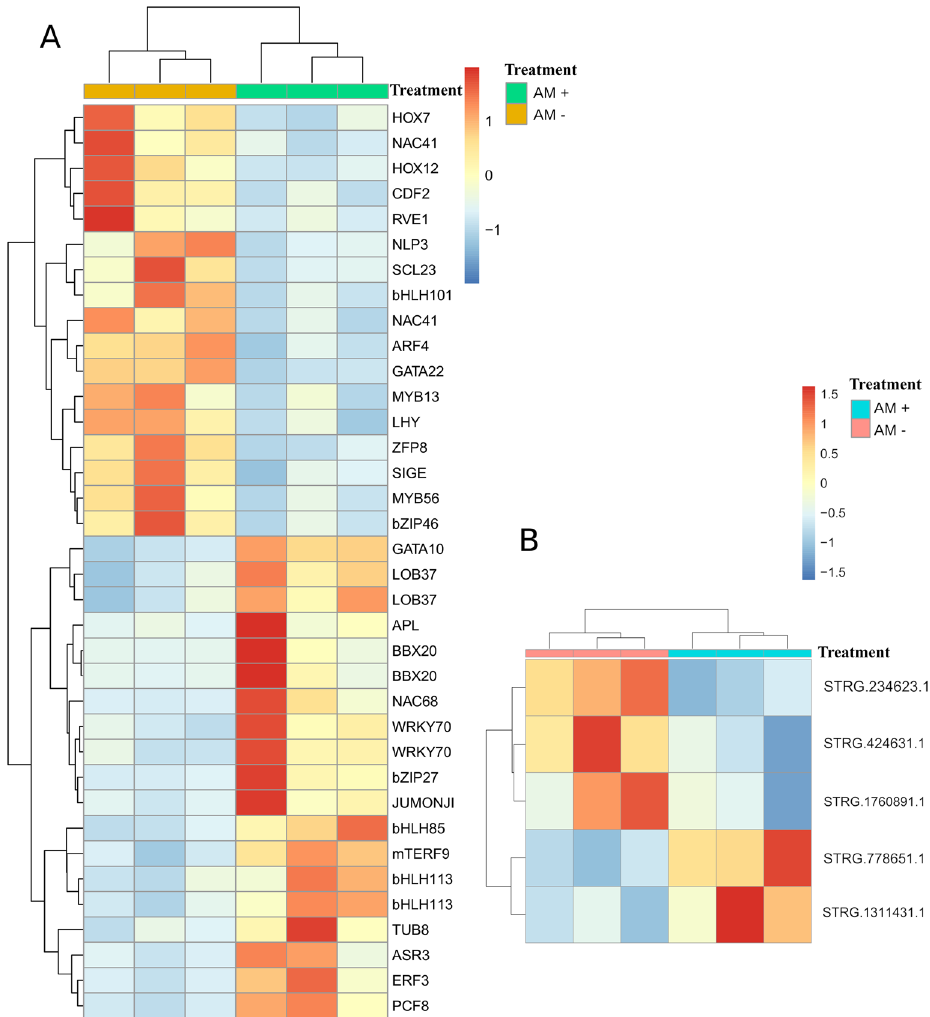
Figure 3. Expression patterns and hierarchical clustering of the 36 Transcription Factors identified comparing the AM + (green) and AM− (yellow) conditions ( A ). Heatmap showing the lncRNA differentially expressed under salt stress in the AM + (blue) and AM− (pink) conditions ( B ). Both heatmaps were generated using the pheatmap R package (https:// cran.r- proje ct. org/ web/ packa ges/ pheat map/ index. html; version